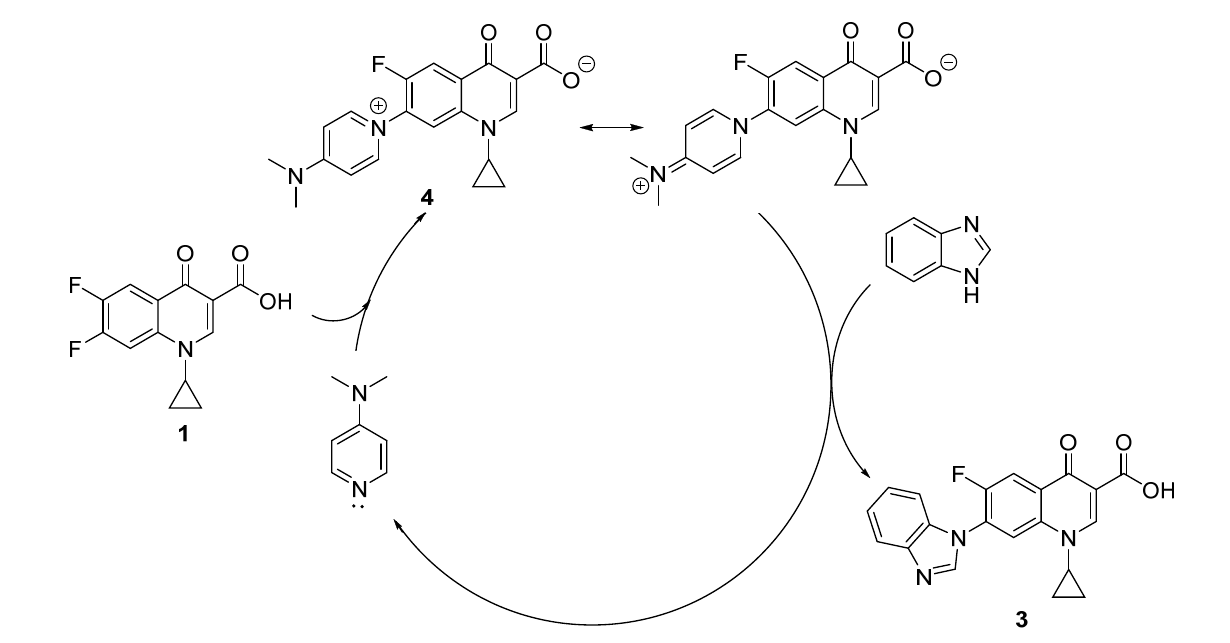
Figure 5. Probable mechanism for the obtention of 3 catalyzed by DMAP .